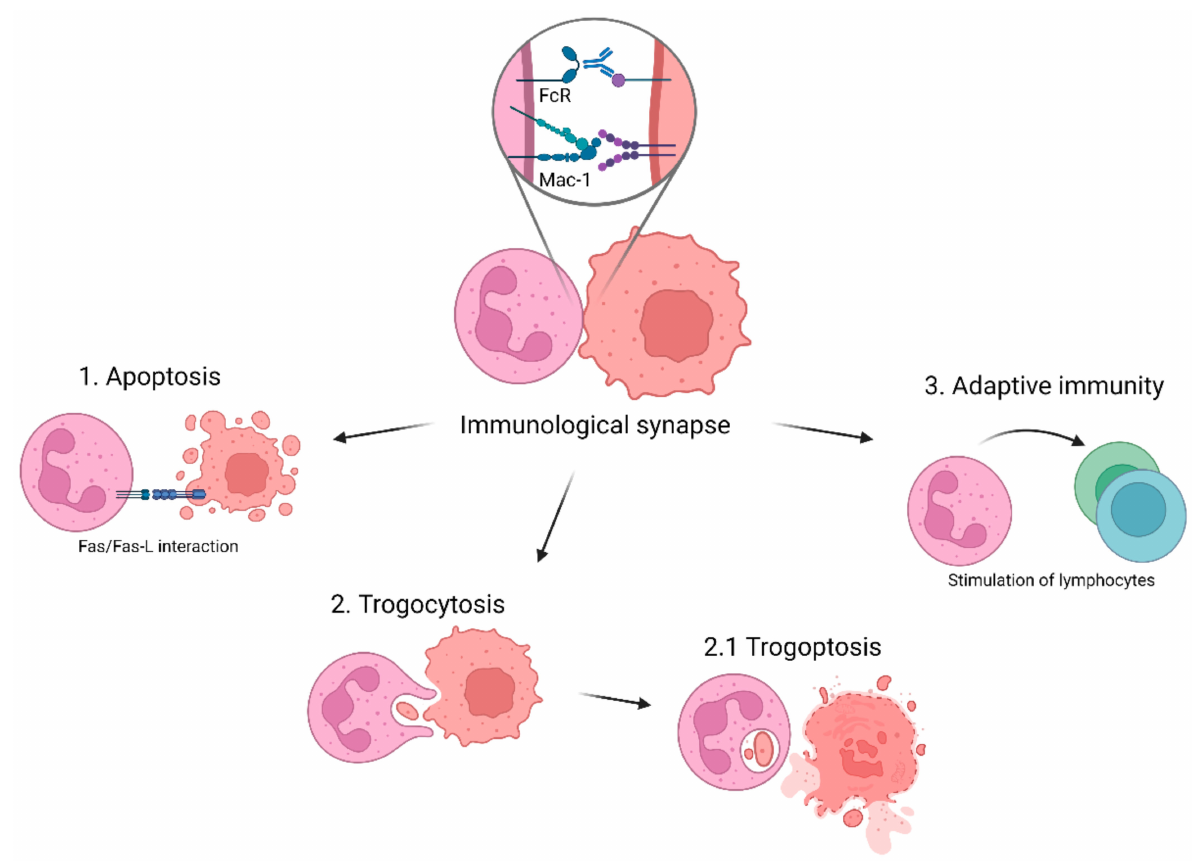
Figure 1. Putative cytotoxic effector functions of neutrophils to kill tumor cells. Neutrophils possess various cytotoxic mechanisms that may play a role in tumor elimination, i.e., induction of apoptosis via Fas/Fas-L interactions, trogoptosis and via stimulation of the adaptive immune